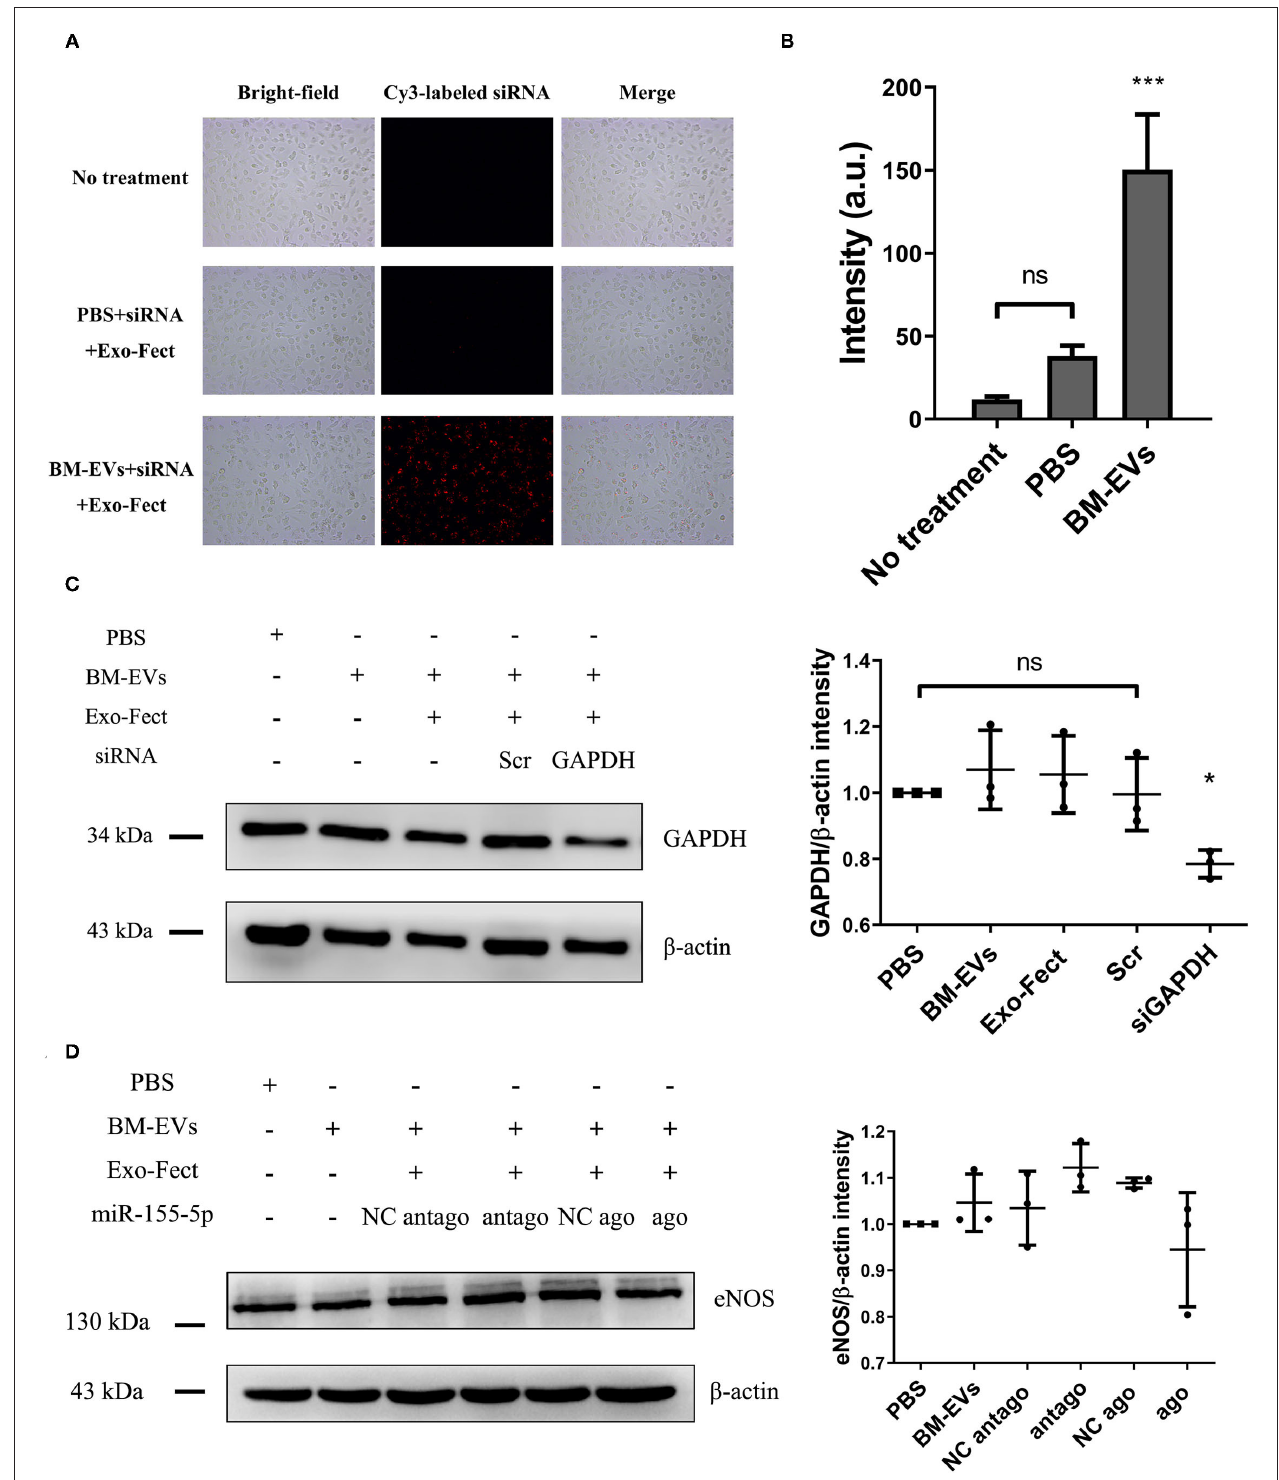
FIGURE 7 | Loading of nucleic acid cargo into BM-EVs by Exo-Fect. (A) siRNA (Cy3-labeled transfection control) was loaded in BM-EVs (150–300 µ g in 100 µ L) by Exo-Fect, delivered to HUVECs, and visualized after 12h transfection. Shown are the bright-field images (left panels), fluorescence images (middle panels), and merged images (right panels). (B) Fluorescent intensity of Cy3-labeled siRNA was quantified using Image-Pro Plus software. (C) After 48-h incubation with modified BM-EVs or controls as indicated, the proteins of β -actin and GAPDH in HUVECs were evaluated by western blotting ( n = 3, mean ± standard deviation). (D) Levels of eNOS and β -actin were measured in HUVECs treated with BM-EVs containing agomiR-155-5p, antagomiR-155-5p and controls ( n = 3, mean ± standard deviation). Scr, scrambled siRNA; NC, negative control; ago, agomiR-155-5p; antago, antagomiR-155-5p; ns, P > 0.05; *, P ≤ 0.05; ***, P ≤ 0.001.